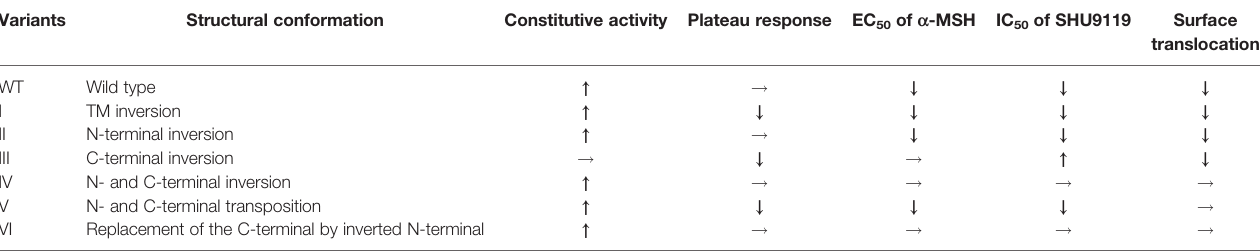
TABLE 1 | Summary of the pharmacological regulation of six melanocortin receptor accessory protein 2 (mMRAP2) variants on melanocortin-4 receptor (mMC4R) signaling.